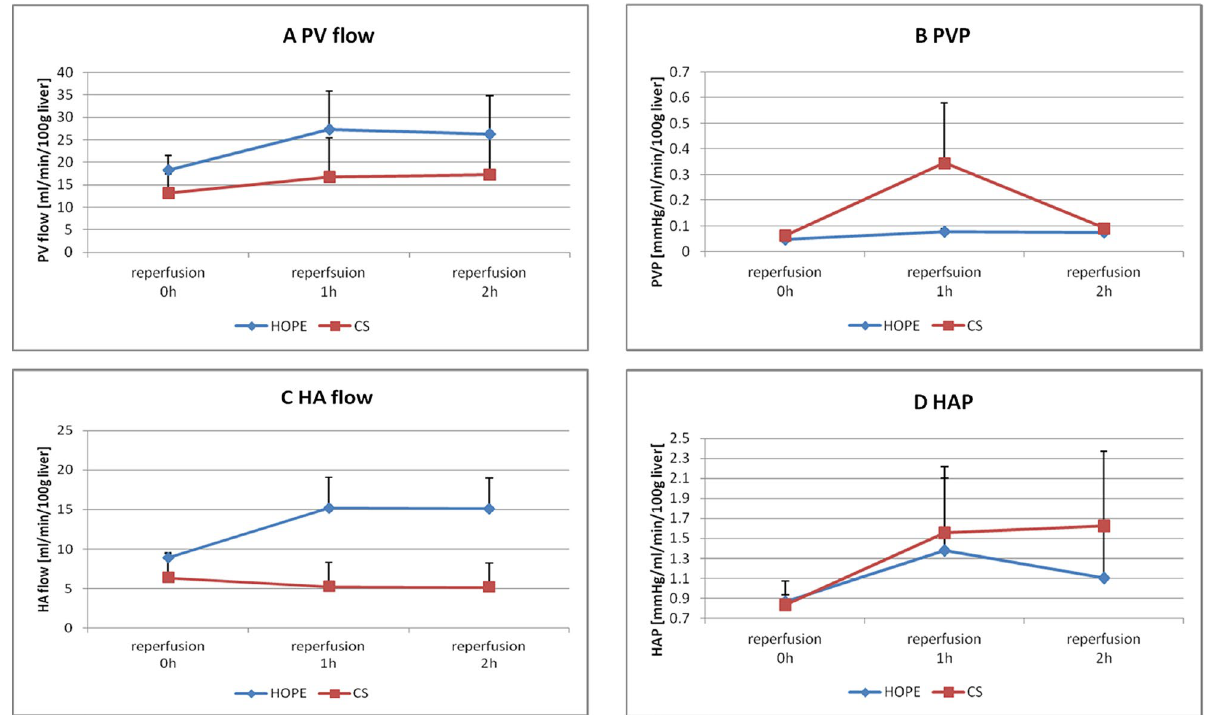
Figure 4. Vascular flow volume and pressure resistance. ( A ) Portal vein flow (mL/min/100 g liver), ( B ) PV pressure (mmHg/mL/min/100 g liver), ( C ) hepatic artery flow (mL/min/100 g liver) and ( D ) HA pressure value (mean ± standard deviation) over time (hours) during the ex vivo reperfusion